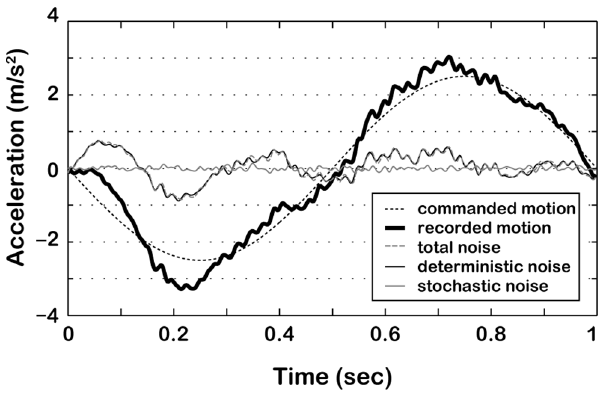
Figure 2. Example of an acquired motion profile and its component. The total noise (grey dashed line) was obtained by subtracting the input command (black dashed line) from the acquired acceleration profile after low-pass filtering (black thick line). The figure also illustrates the deterministic (black thin line) and stochastic (grey thin line) components of the total noise of the recorded profile.